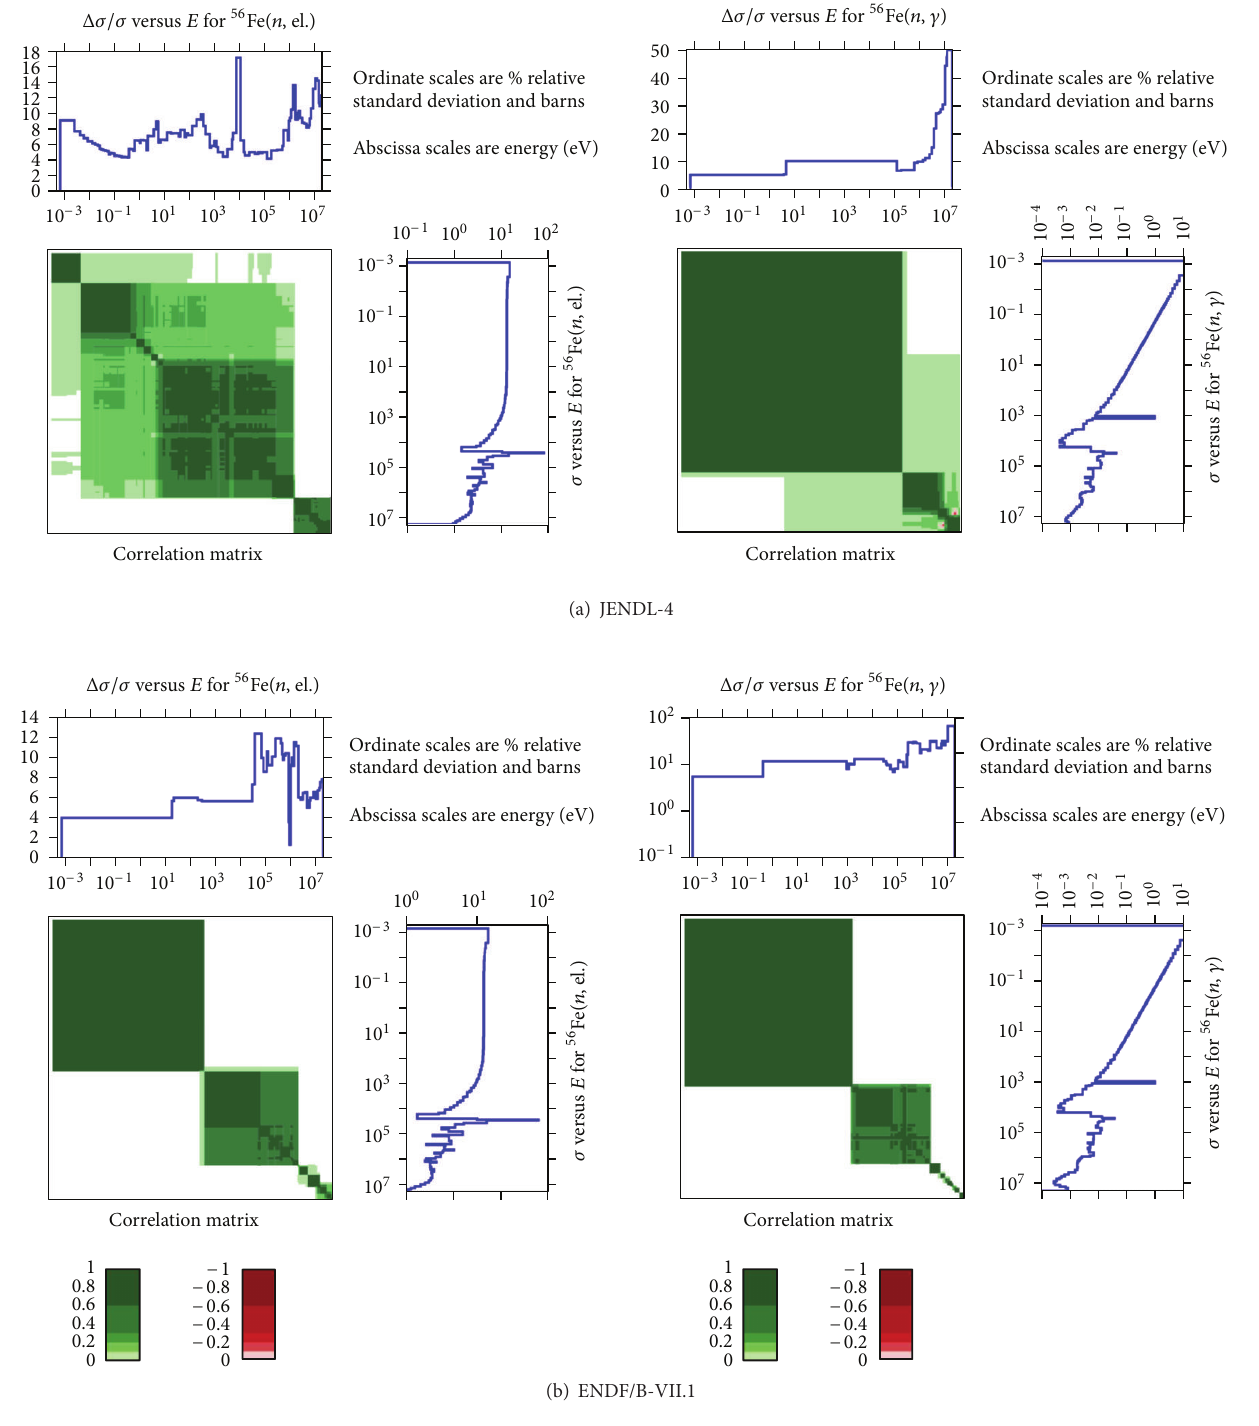
F 3: Covariance plot for